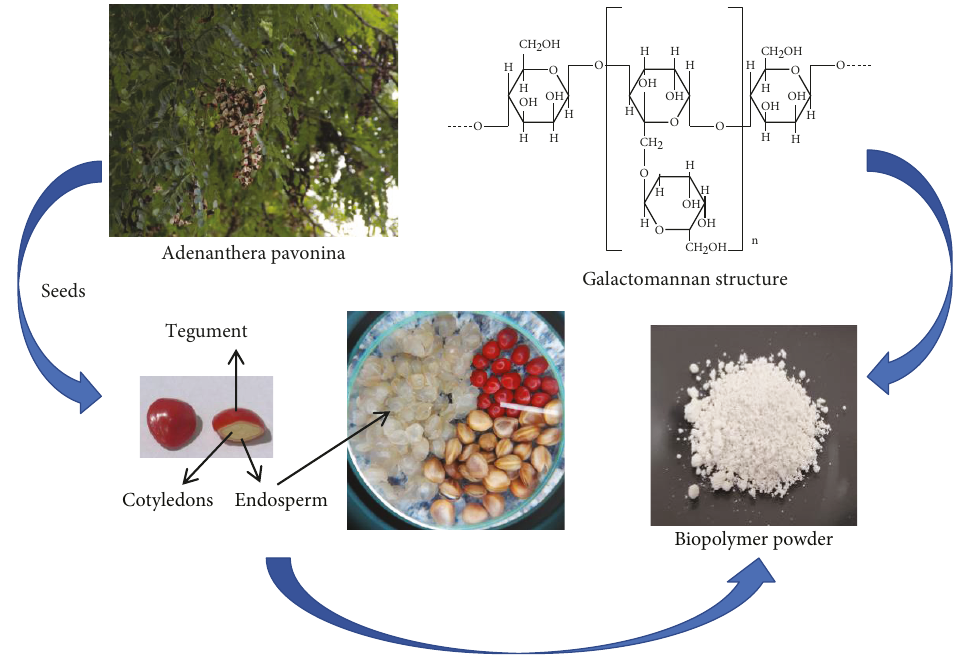
Figure 1: Illustration of the A. pavonina plant, its seeds, and the galactomannan extracted from its